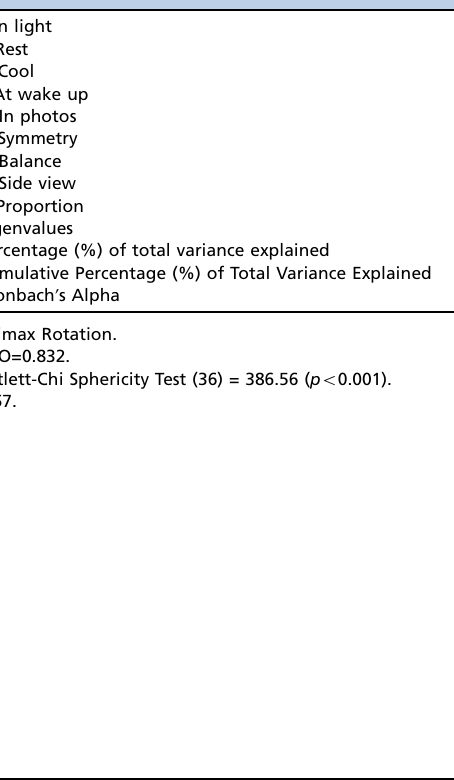
Table 1 - Factorial loads, eigenvalues, percentage of explained variance and Cronbach ’ s alpha coefficient of the two factors of the Face-Q SFAOS. Factors Face appearance 1 2